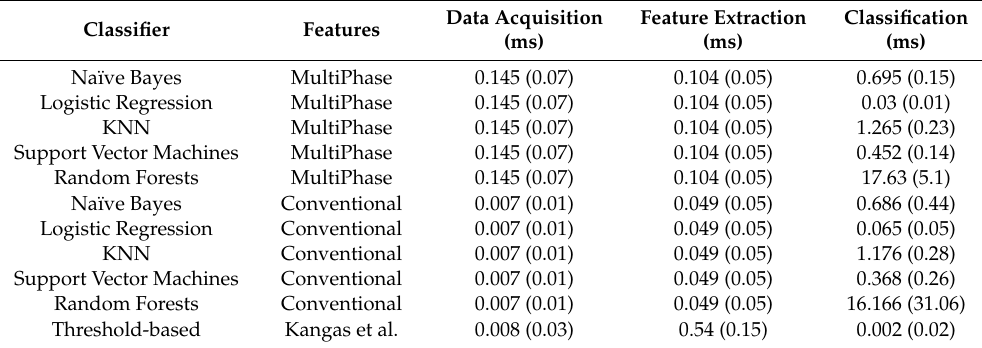
Table 4. Computational time for a single